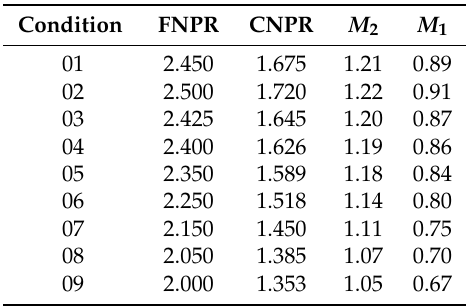
Figure 9. The parametric investigation chart. The perfectly expanded condition is shown as a reference, but it is not the subject of investigation. Table 2. The pressure parameters of the simulation campaign with the relative fully-expanded Mach number, for several test